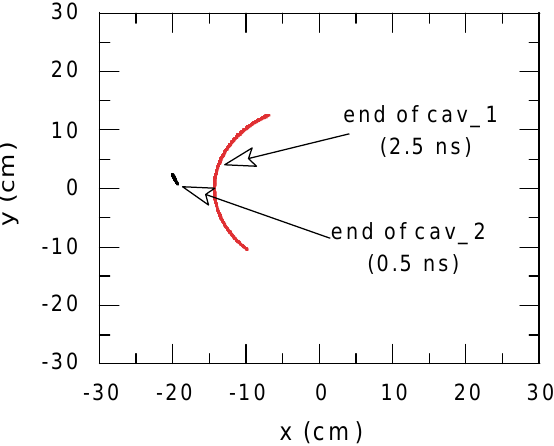
FIG. 5. rms spread in resonance phase along the accelerator. The phase spread in the first cavity drops rapidly from 0.28 rad to nearly zero, since the injected beam is taken to have zero emittance. The oscillatory character of this spread is evidence of dynamic (longitudinal) stabilization.